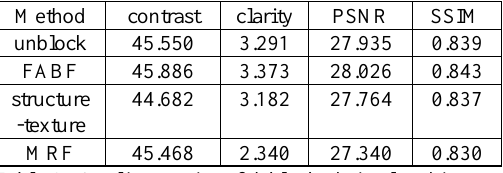
Table 2. Quality metrics of deblocked simulated